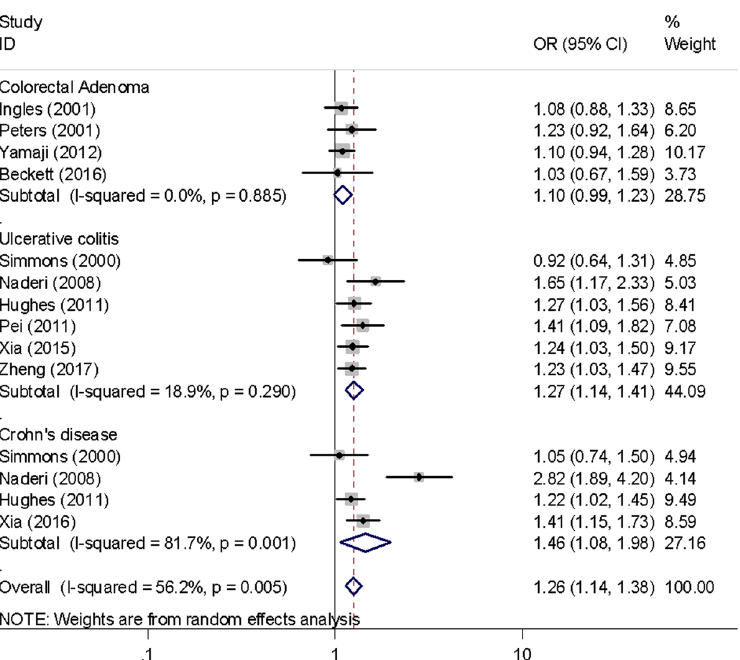
Figure 2. Forest plot showing the risk of colorectal adenoma and inflammatory bowel disease associated with VDR Fok I polymorphism (f allele vs. F